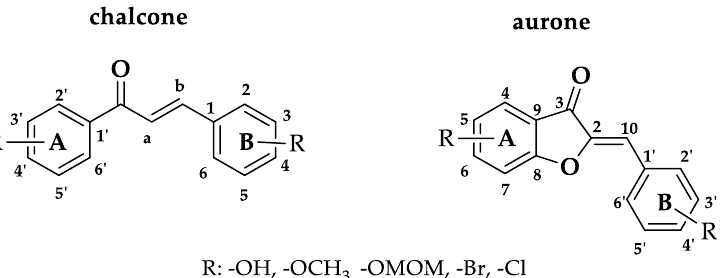
Figure 1. General structure and numbering scheme of the chalcone and aurone framework.